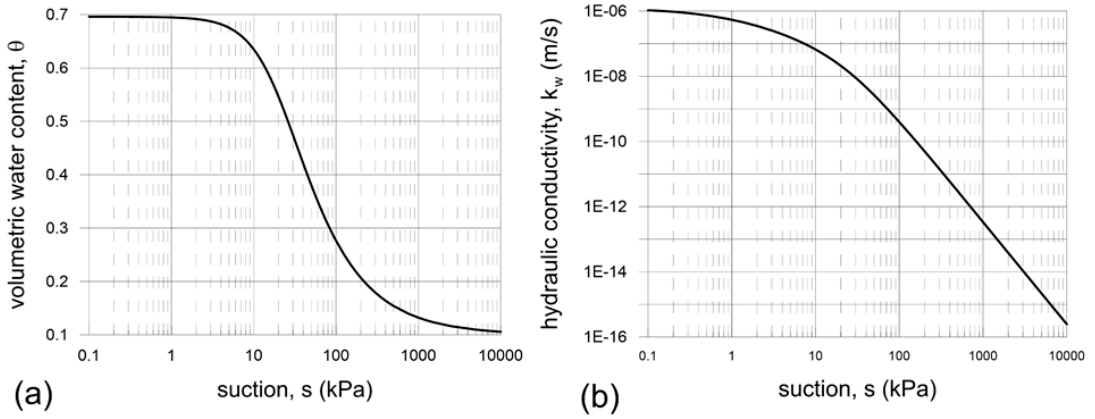
Figure 4. Material hydraulic properties assessed by means of physical model of lysimeter: ( a ) soil-water characteristic curve (SWCC); ( b ) hydraulic conductivity function (modified by Reder et al. [34]).